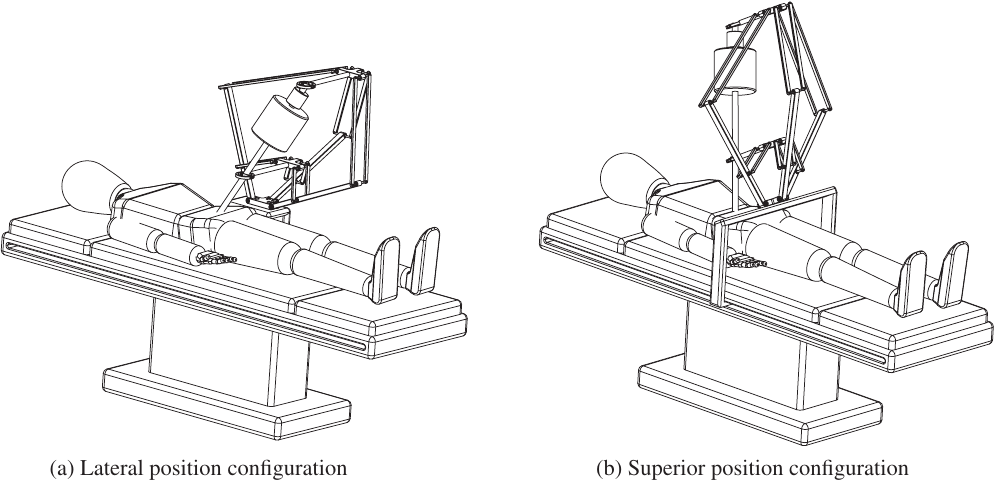
Fig. 9. Example of potential working configurations for the Dionis manipulator.